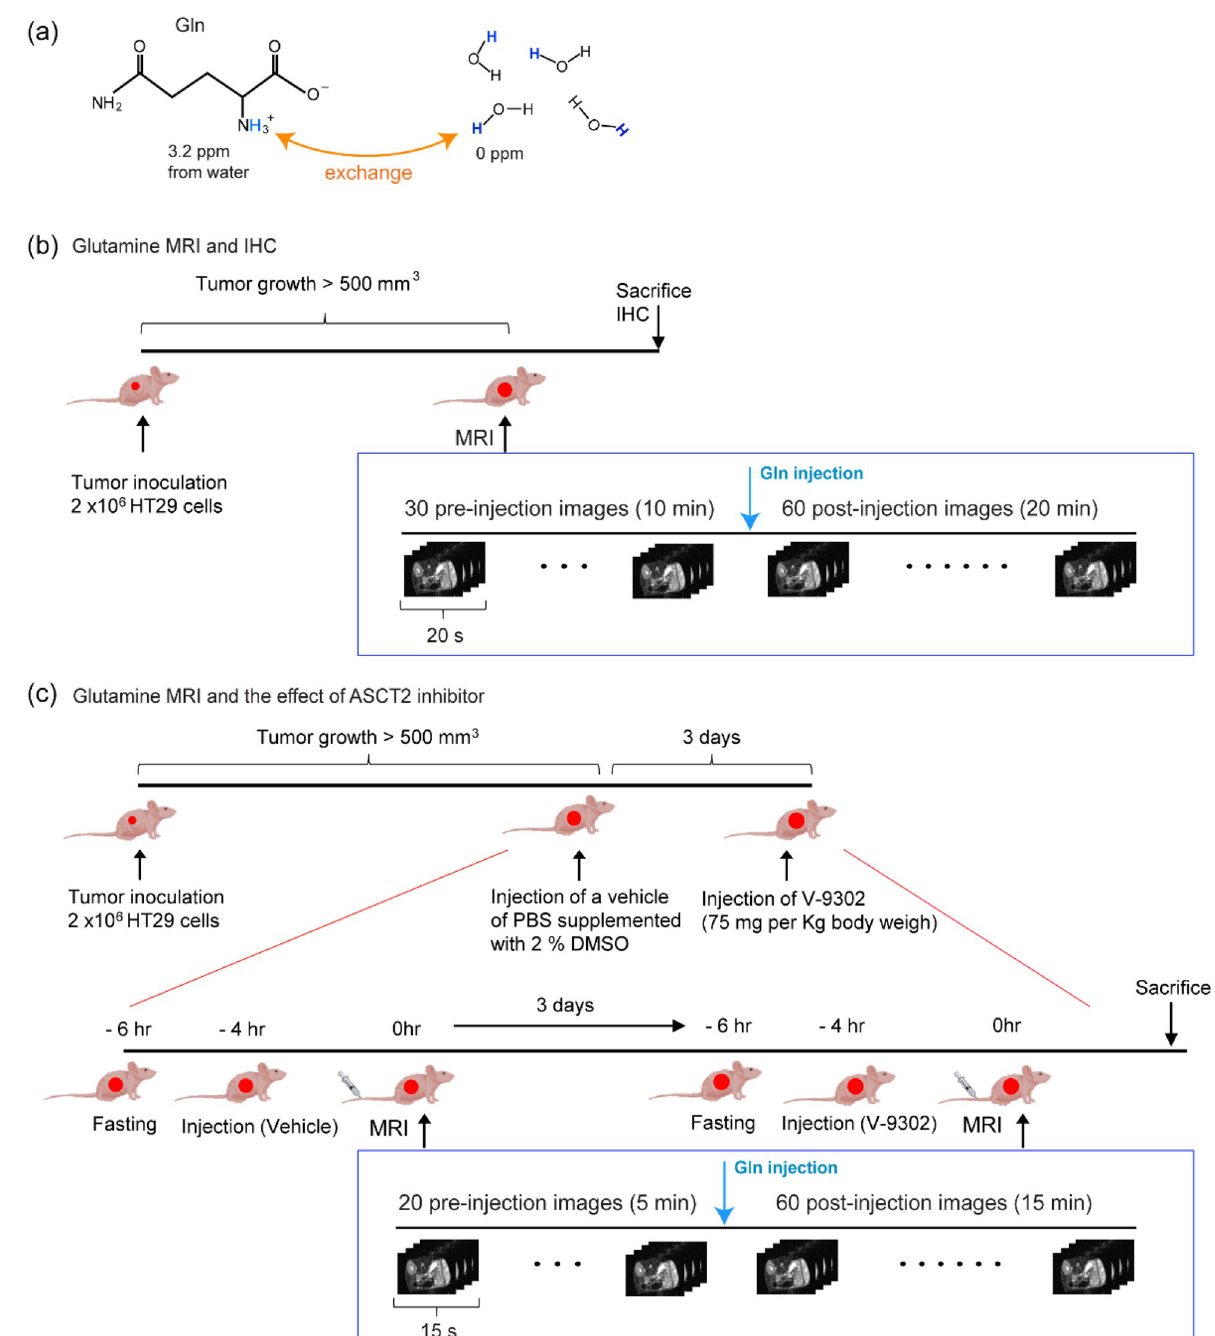
Figure 1. The principle of glutamine magnetic resonance imaging (MRI) and experimental design using an in vivo xenograft model. ( a ) The structure of glutamine. The amine protons of glutamine are exchanged with water protons. The chemical shift indicated here is in reference to the water signal. ( b ) Experimental design for investigating the correlation between MRI assessment of glutamine uptake and distribution of ASCT2 and CSC markers. ( c ) Experimental design for examining the effect of ASCT2 inhibitor V-9302 on MRI assessment of glutamine the paired t -test performed on the data in Fig. 4b,c for each time point are presented in Fig. 4d as p1 and p2, respectively. A statistically significant change in the 6-min post glutamine injection time period was observed. The analysis of the number of pixels (Fig. 4e) and the relative area (Fig. 4f) with more than 4% intensity change was also statistically significant.